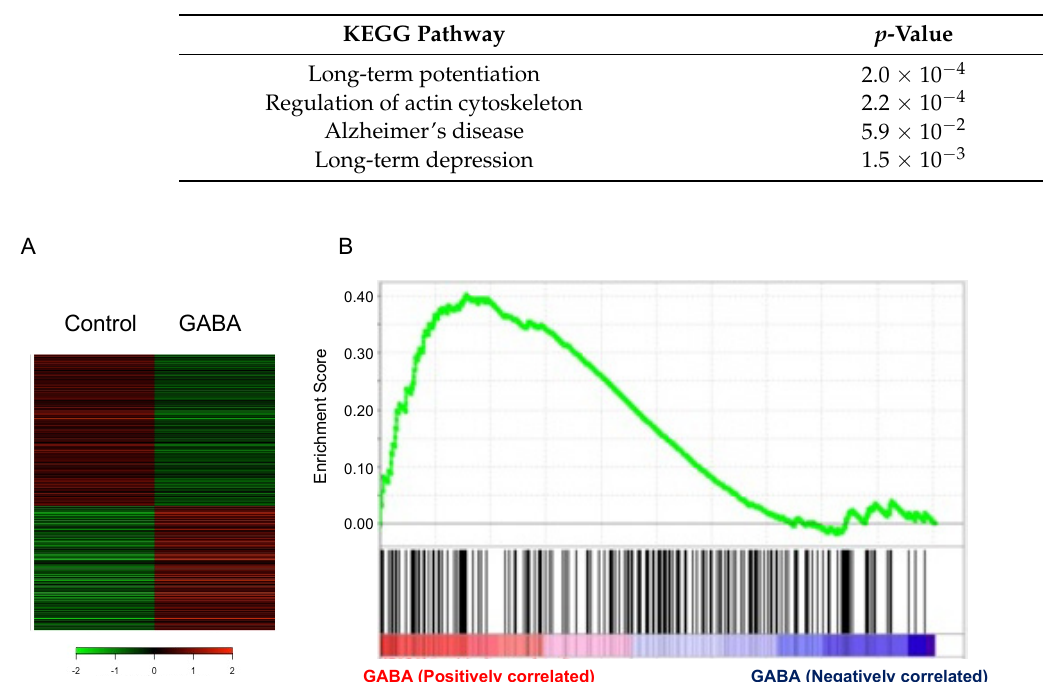
Figure 6. Microarray analysis of genes in the hippocampus of GABA-treated mice. ( A ) Heatmap was used to visualize differential expressed genes. ( B ) Gene set enrichment analysis (GSEA) analysis of gene sets relating to memory in the hippocampus of GABA-treated mice. Enrichment plots (green curve) show the running sum of enrichment score (ES) for memory-related gene set. The score at the peak of the plot is the ES for the gene set. The black bars show where the member of the gene set appear in the ranked list of genes. Each black bar represents a memory-related gene. A predominance of black bars to the left or right side indicates that these genes are up-regulated or down-regulated in the hippocampus of GABA-treated mice. Table 4. Functional categories of genes differentially expressed in the hippocampus of GABA- 292 administered mice. 293